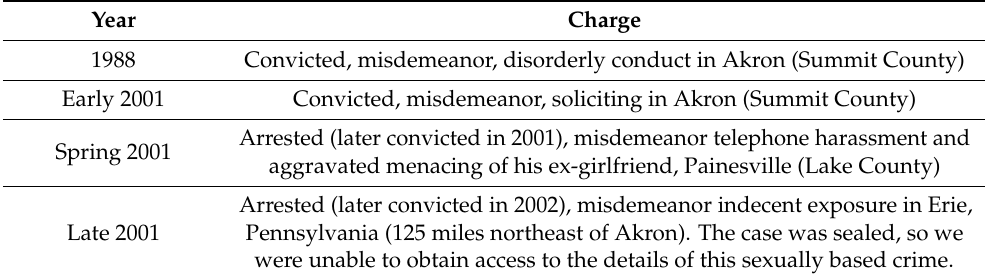
Table 1. Summary of the Offender’s Criminal History by Year and